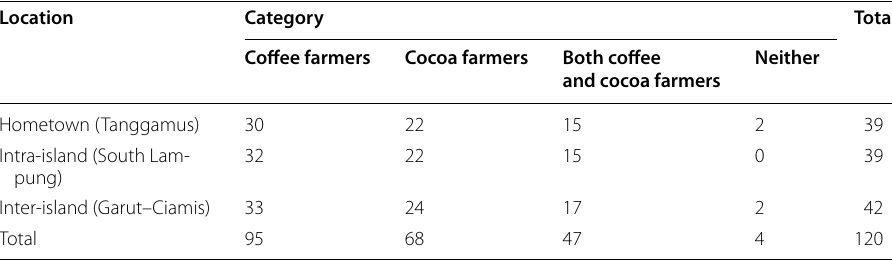
Table 1 Training participants according to training heterogeneity Location